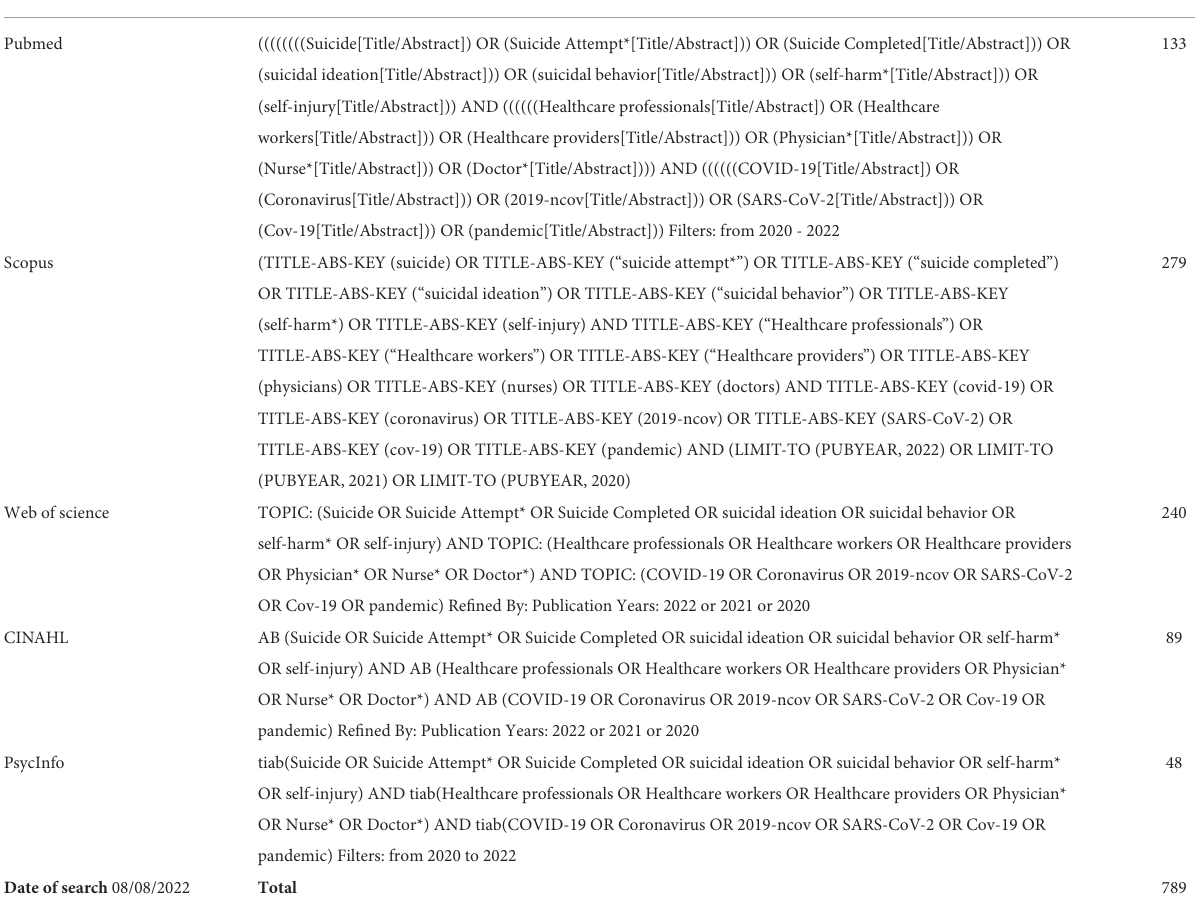
TABLE 3 Search strategy for each